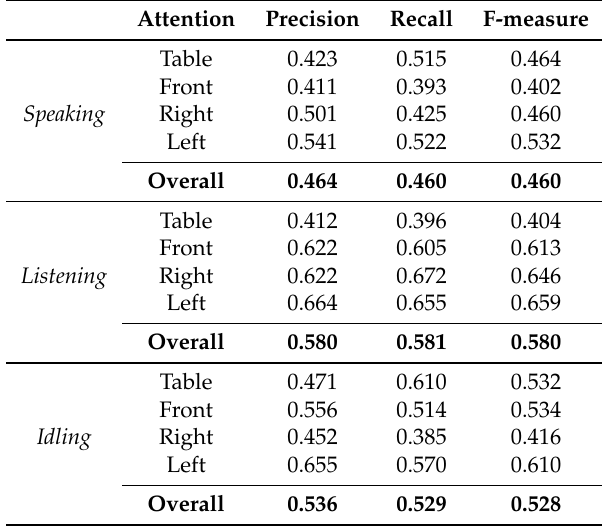
Table 4. Classification results of speaking, listening, and idling models with all available feature sets and optimized window lengths.